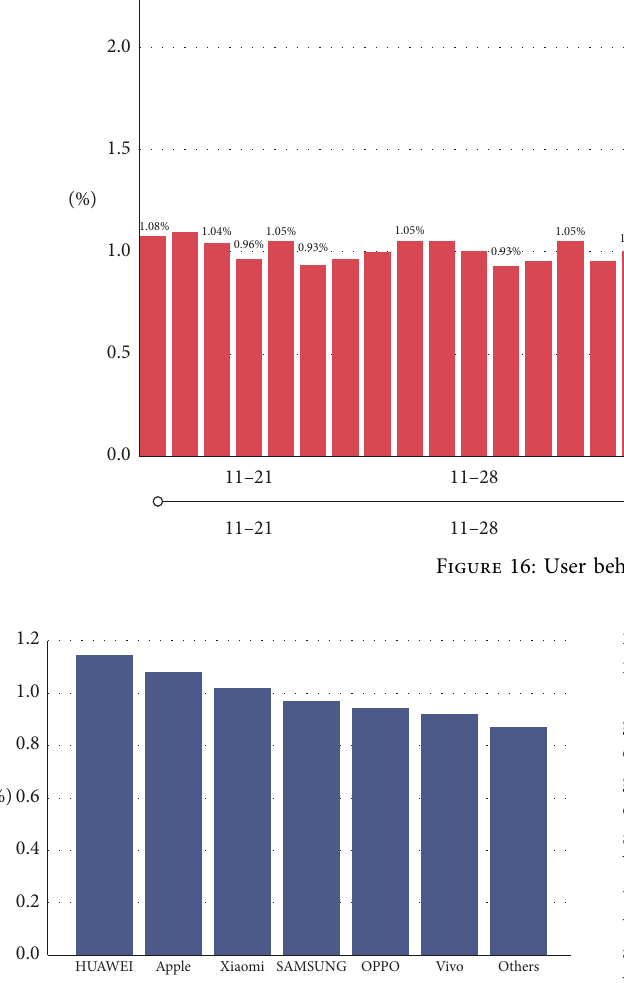
Figure 17: User daily payment